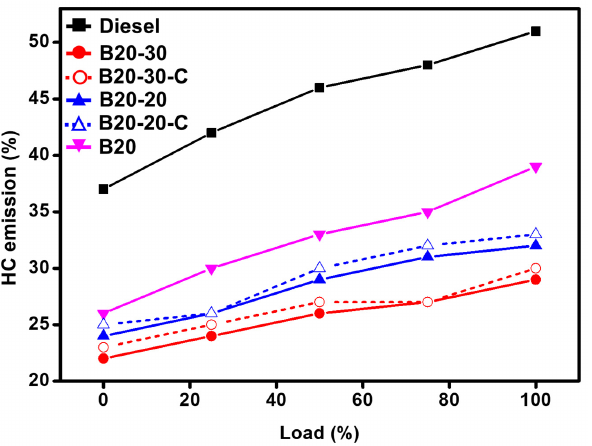
Figure 11. Comparative graphical illustration of emission of hydrocarbons (HC) vs. load (%) (with ZnO-GS and ZnO-C). B20 is D-COME, i.e., discarded cooking oil methyl ester, which is blended with 20% commercial diesel; B20-20 is the blend of B20 with 20 mg of ZnO-GS/C; B20-30 is the blend of B20 with 30 mg of